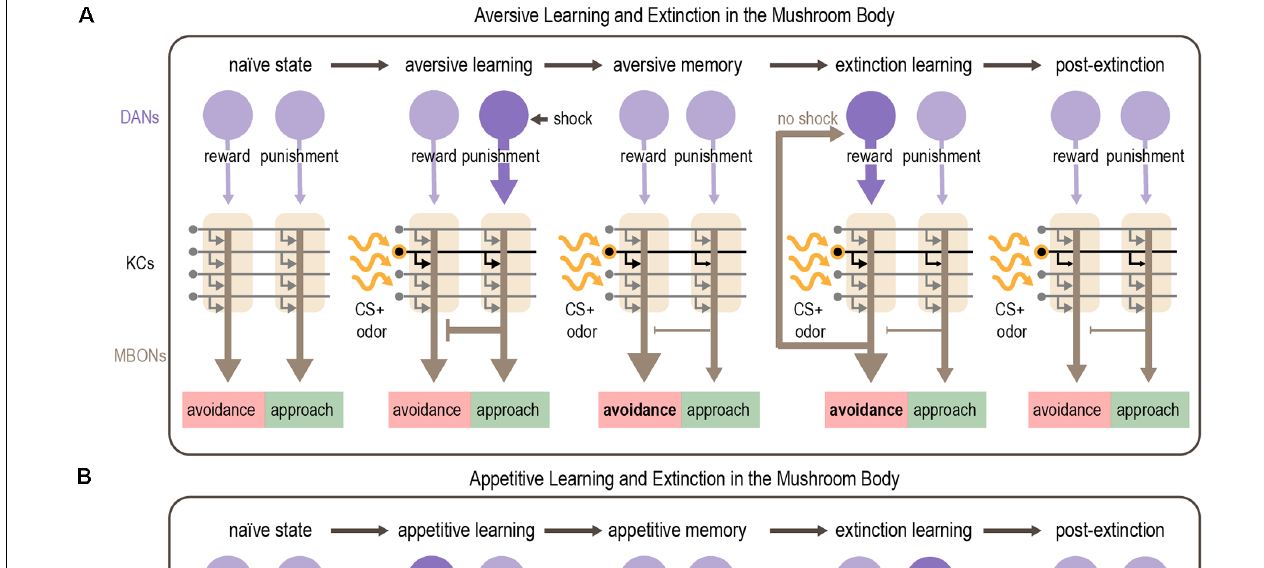
FIGURE 6 | Mechanism for associative learning, extinction learning, and reconsolidation in the MB. (A,B) Plasticity in MB circuits mediates aversive (A) and appetitive (B) learning. Odor sparsely activates KCs within the MB. Aversive cues activate punishment-encoding DANs, which modulate MBONs promoting approach, whereas appetitive cues activate reward-encoding DANs, which modulate MBONs promoting avoidance. Dopamine depresses active KC-MBON synapses. After aversive learning, this depression shifts the balance of MBON activity towards avoidance (A) whereas after appetitive learning the balance shifts towards approach (B) . Extinction of aversive or appetitive memories occurs by readjusting the balance of MBON activity. After aversive learning, presenting the CS+